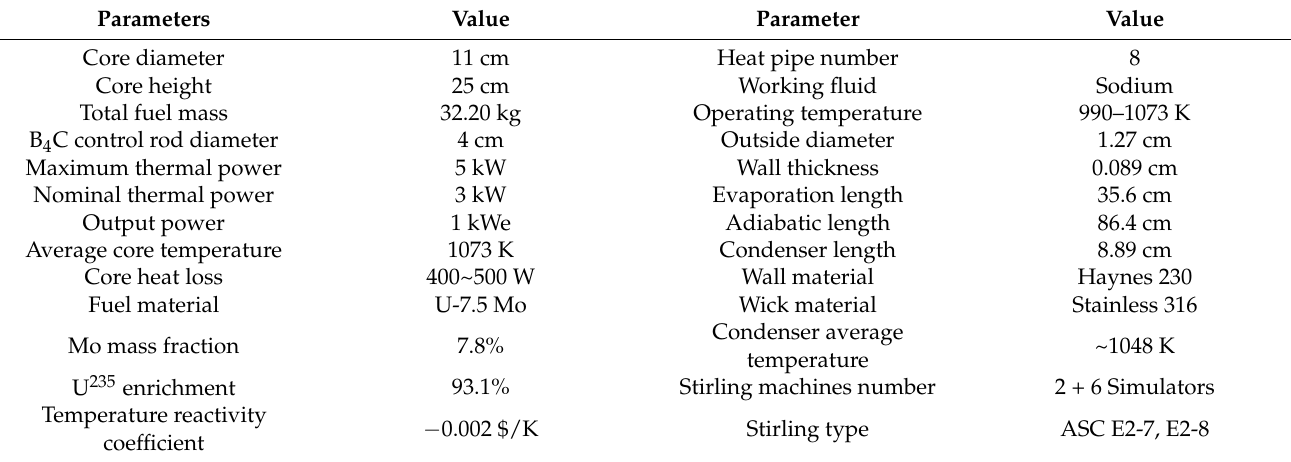
Table 2. Neutron physical parameters in the KRUSTY core.